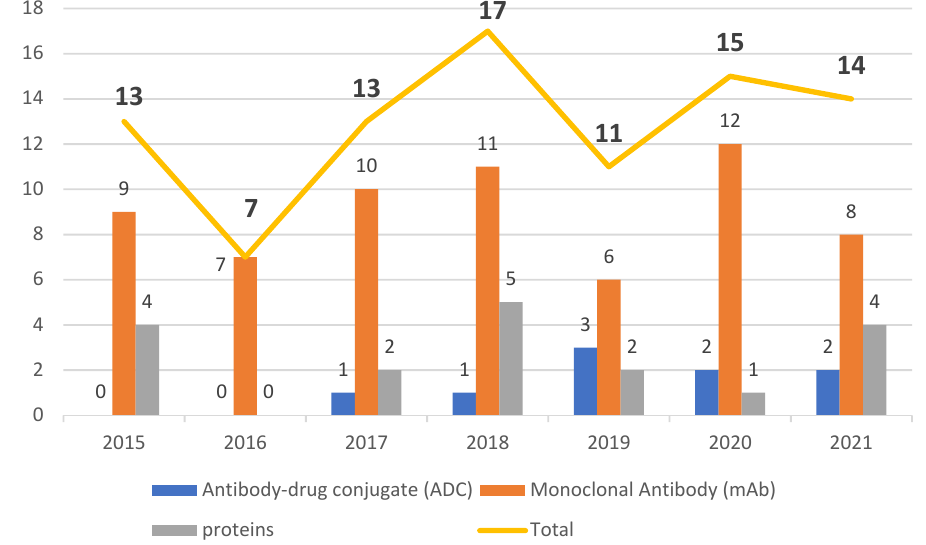
Figure 2. Biologicals approved by the Food and Drug Administration (FDA) from 2015 to 2021 [2,15–21].